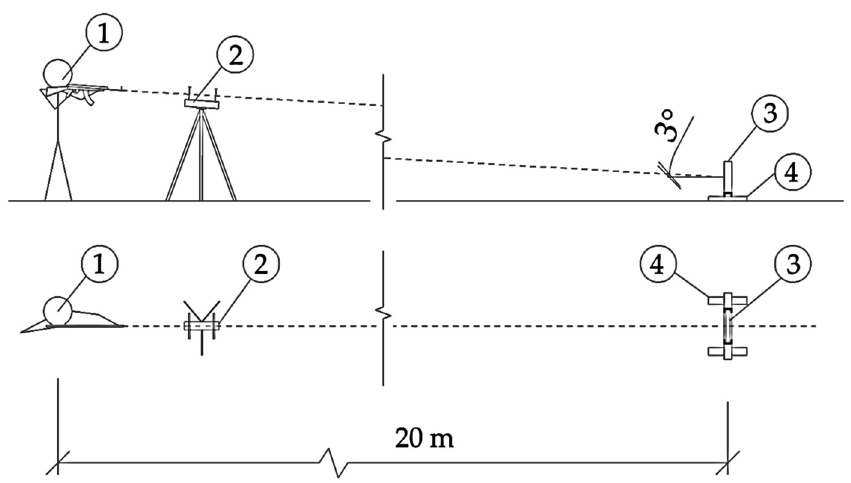
Figure 5. Ballistic test schematics; (1) Shooter, (2) Chronograph, (3) Test specimen, (4) Specimen mounting structure.